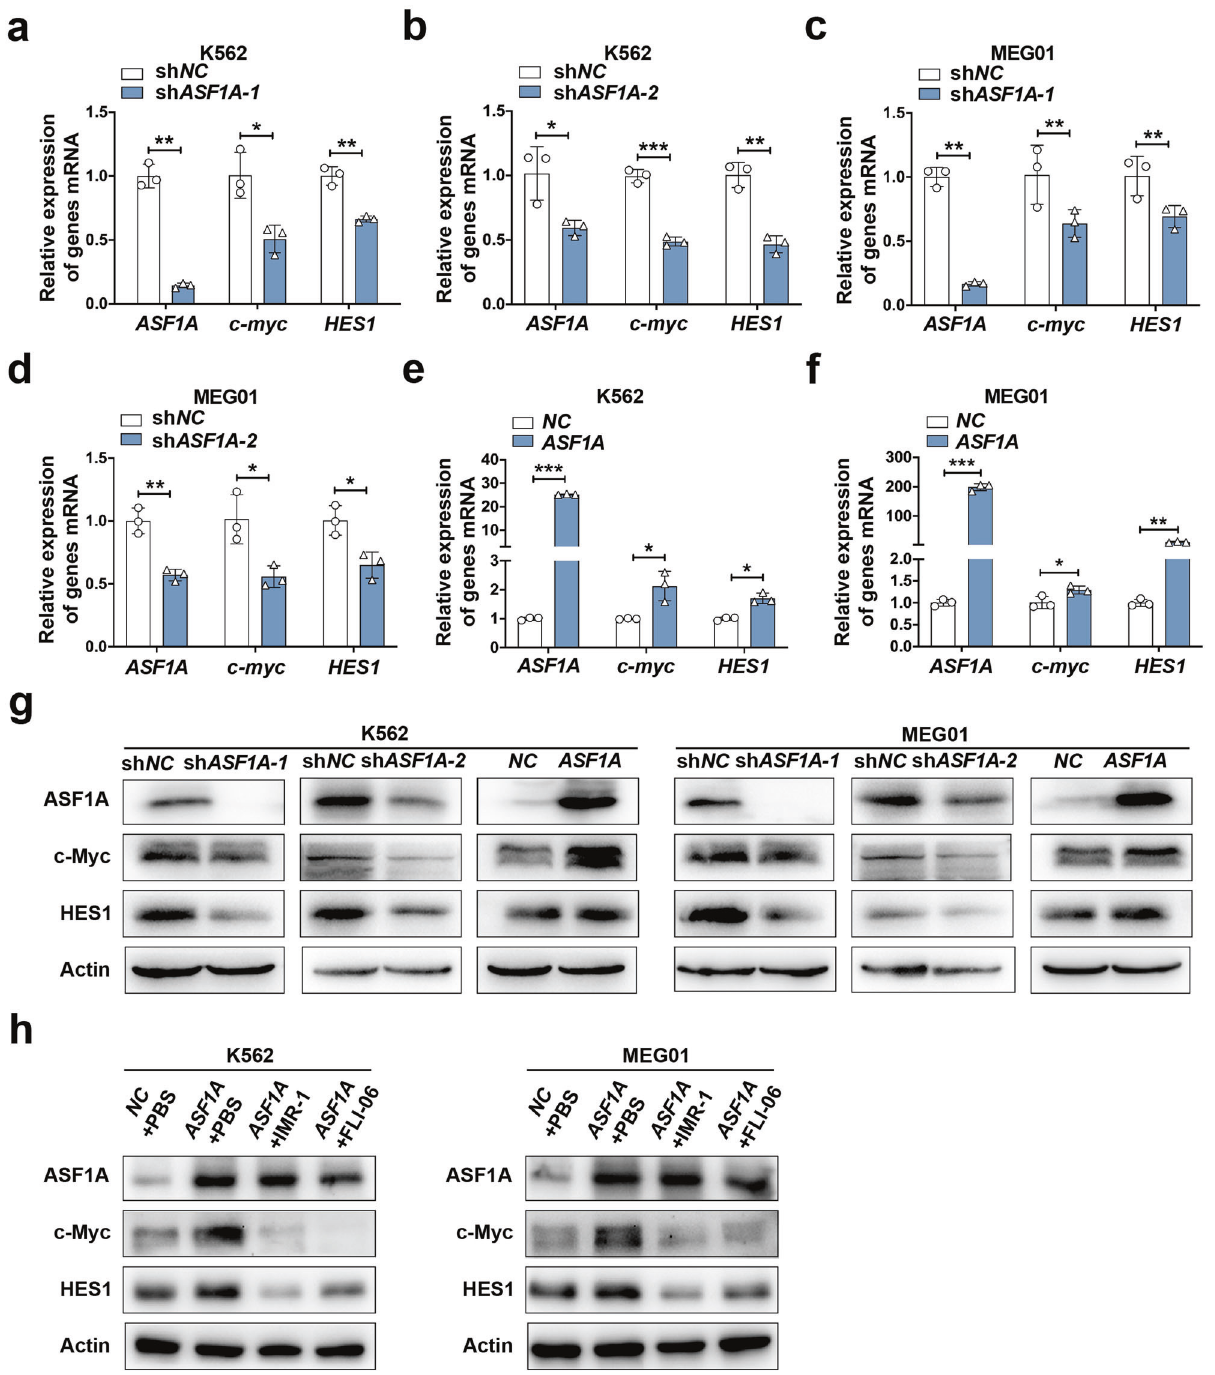
Fig. 4 ASF1A promoted Notch signaling activation. a , b qRT-PCR analysis of ASF1A , c-Myc , and HES1 mRNA levels in K562 cells expressing empty vector (shNC) or shASF1A-1/shASF1A-2. c , d qRT-PCR analysis of ASF1A , c-Myc , and HES1 mRNA levels in MEG01 cells expressing empty vector (shNC) or shASF1A-1/shASF1A-2. e , f qRT-PCR analysis of ASF1A , c-Myc , and HES1 mRNA levels in K562 and MEG01 cells expressing either empty vector (NC) or ASF1A. g Western blot analysis of ASF1A, c-Myc, and HES1 in K562 and MEG01 cells transfected as indicated. Statistical signi fi cance was determined by Student ’ s t test. Data are shown as mean ± standard deviation (SD). Data are shown as a representative result with three repeats from three independent experiments. The cell lines are applied with three independent lentiviral infections in a – g . * P < 0.05, ** P < 0.01, *** P < 0.001. h Western blot analysis of ASF1A, c-Myc, and HES1 in K562 and MEG01 expressing either empty vector (NC) or ASF1A, treated with control, IMR-1 (20 μ M) or FLI-06 (5 μ M) for 48 h. Data are shown as a representative result with three repeats from three independent experiments. The cell lines are applied with three independent lentiviral infections and then treated with the compounds in h .